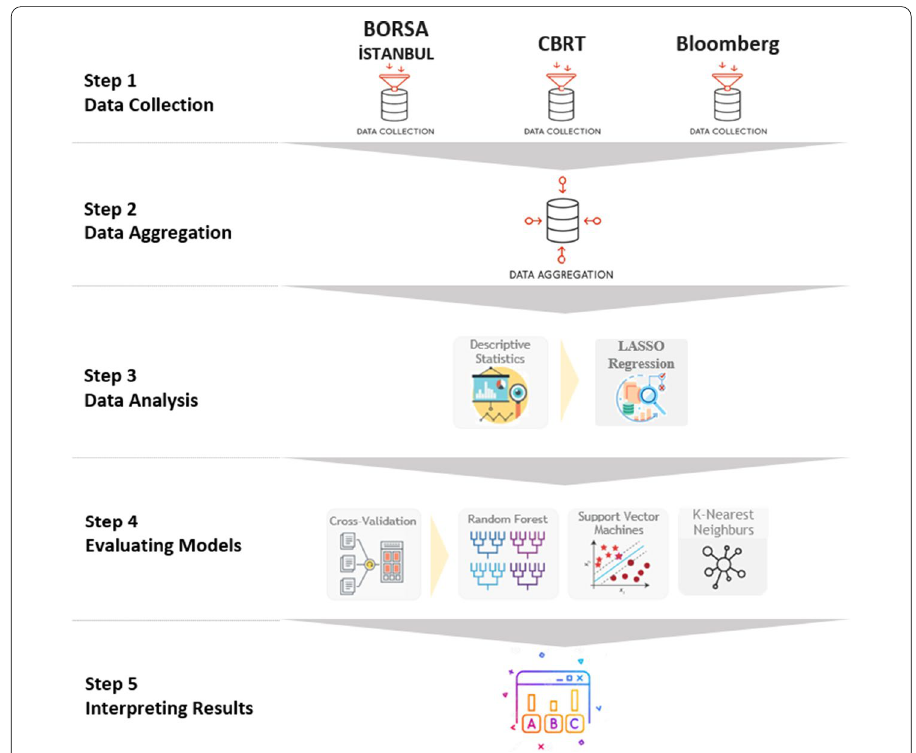
Fig. 3 The process of the methodology in the research. Source : Authors’